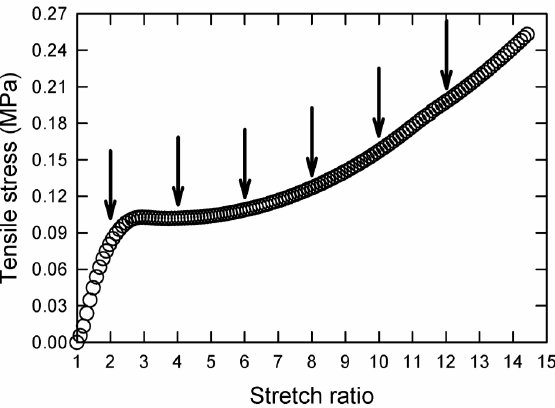
Figure 2. Engineering tensile stress versus stretch ratio for a pseudo-IPN hydrogel made of AMPS(1,2,2,9) and AAm(2,0.1,0.01,97). Arrows display the stretch ratios at which drying tests were performed on the samples.